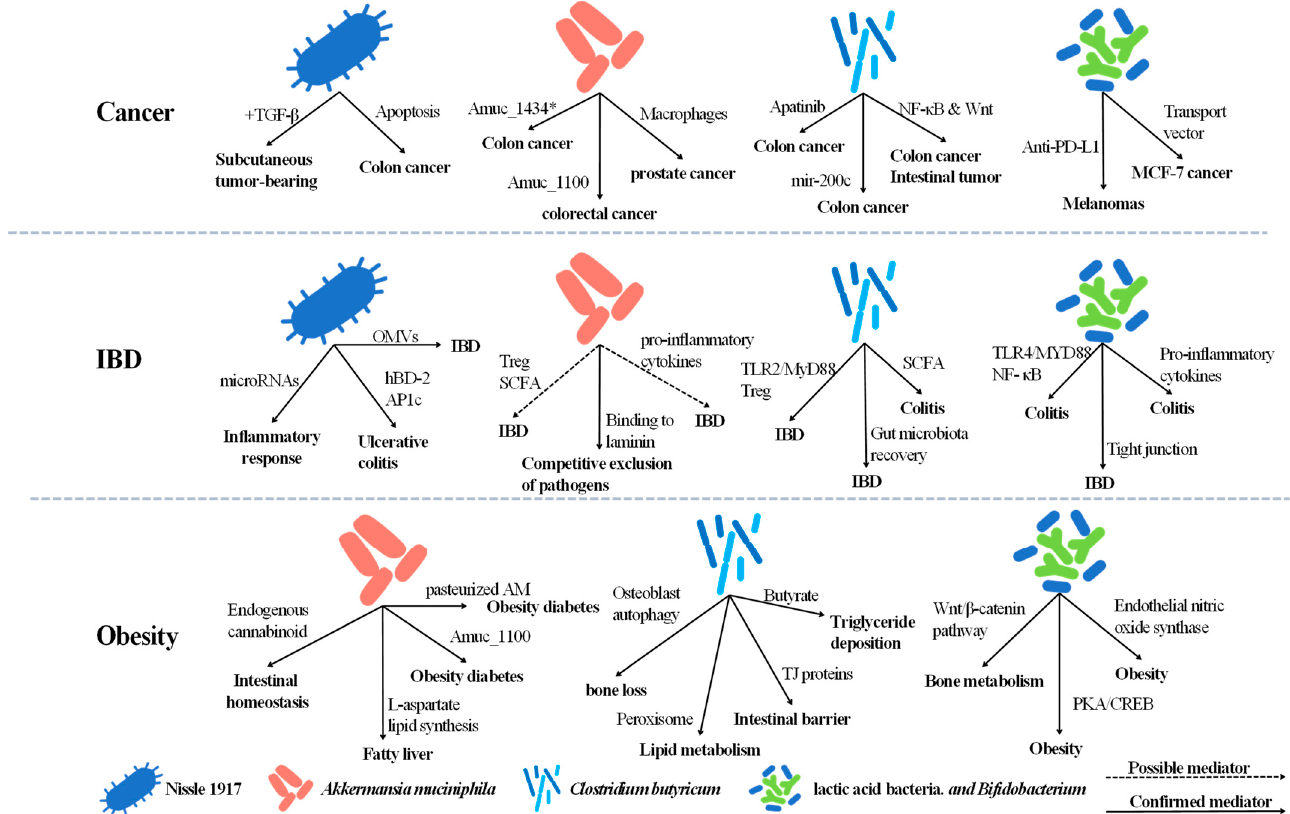
Figure 1. Effects of native probiotics in diseases. Escherichia coli Nissle 1917, Akkermansia muciniphila , Clostridium butyricum , lactic acid bacteria, and Bifidobacterium spp. have been proven to be promising therapeutic agents in cancer, IBD, and obesity.